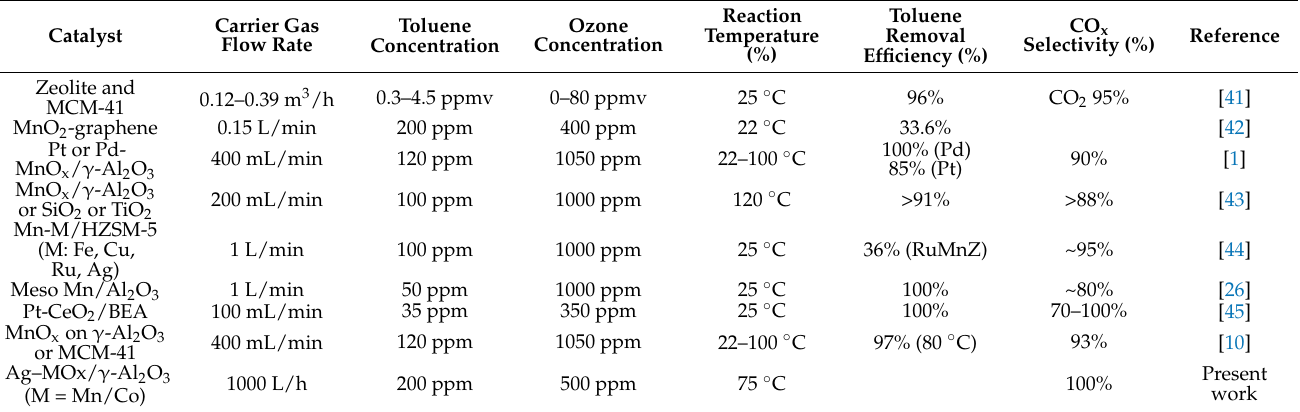
Table 3. A comparision of literature studies and the present study for catalytic ozonation of